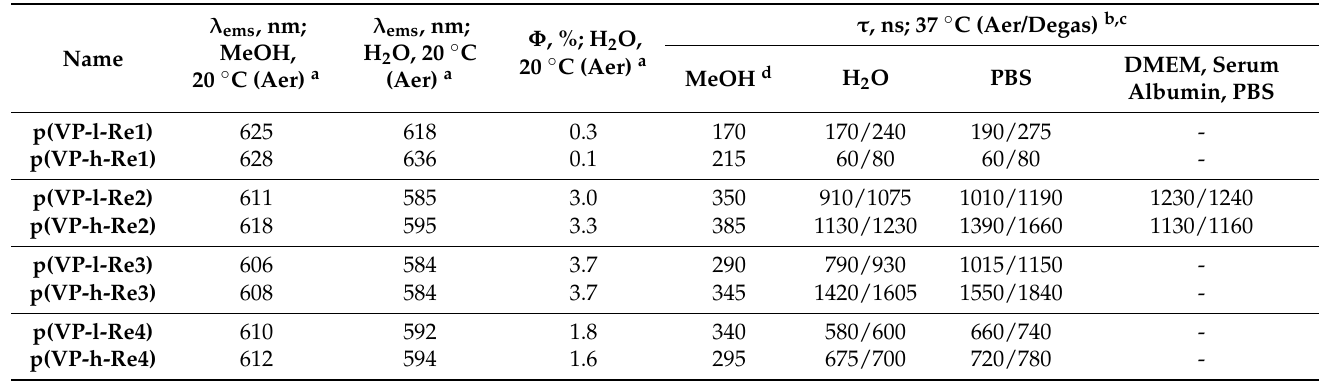
Table 3. Photophysical properties of p(VP-l-Re) and p(VP-h-Re) in fluid